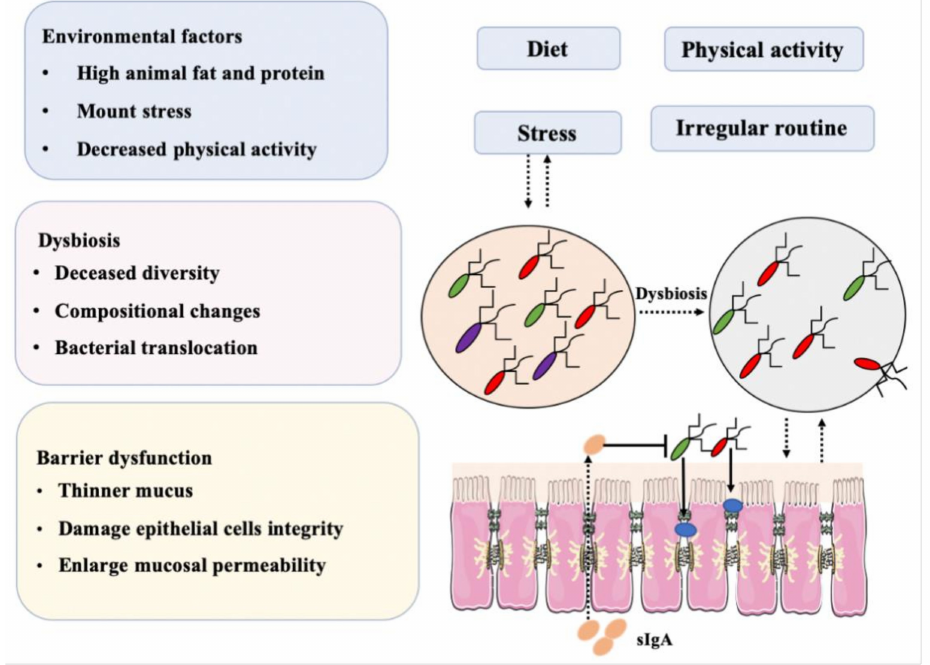
Figure 4. Combination of factors, mainly diet and dysbiosis, that may induce